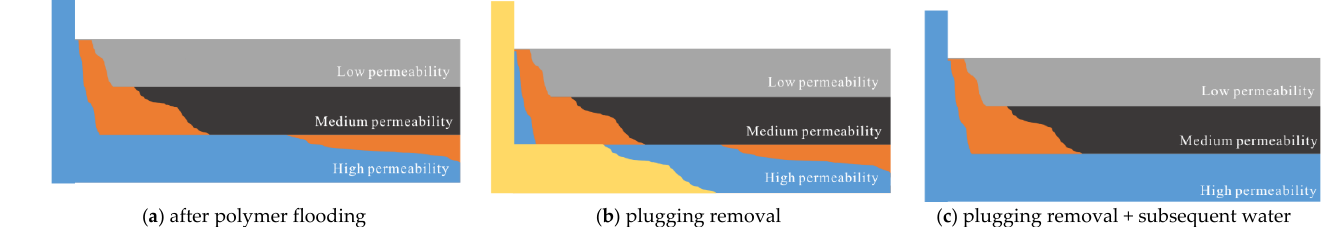
Figure 11. General plugging removal mechanism ( a ) after polymer flooding, ( b ) plugging removal and ( c ) plugging removal + subsequent water flooding.